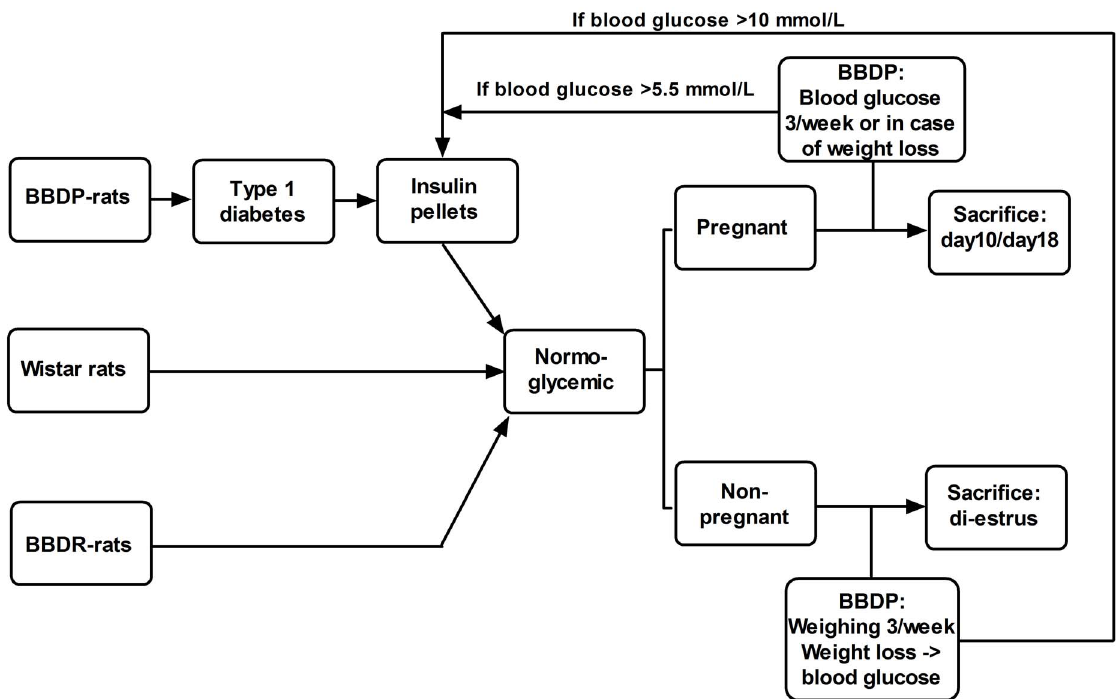
Figure 1. Flowchart of the experimental design.